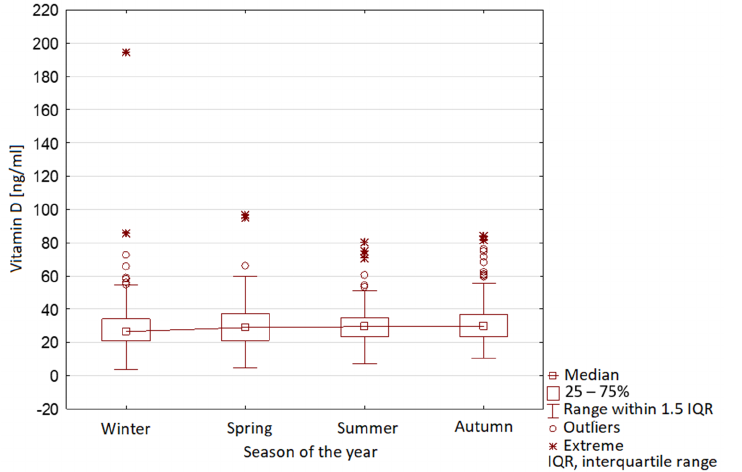
Figure 10. Vitamin D serum level range in year seasons in children during COVID-19 pandemic